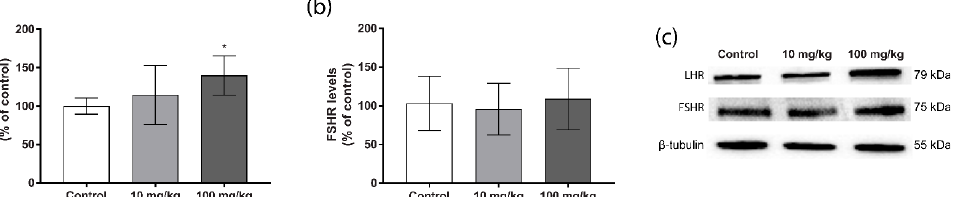
Figure 4. Persistent effects of five weeks oral DBP exposure on testicular oxidative stress in adult mice. Levels of nitrotyrosine were measured by Western blot in mouse testis collected one week after the last DBP administration. Values represent mean ± S.D. from 12 animals per group. Repre- sentative blots of three experiments are shown below the graph. β -tubulin was used as a loading control. Statistically significant differences from control are indicated as follows: ** p < 0.01 and * p < 0.05 (One-way ANOVA followed by Dunnet’s test).